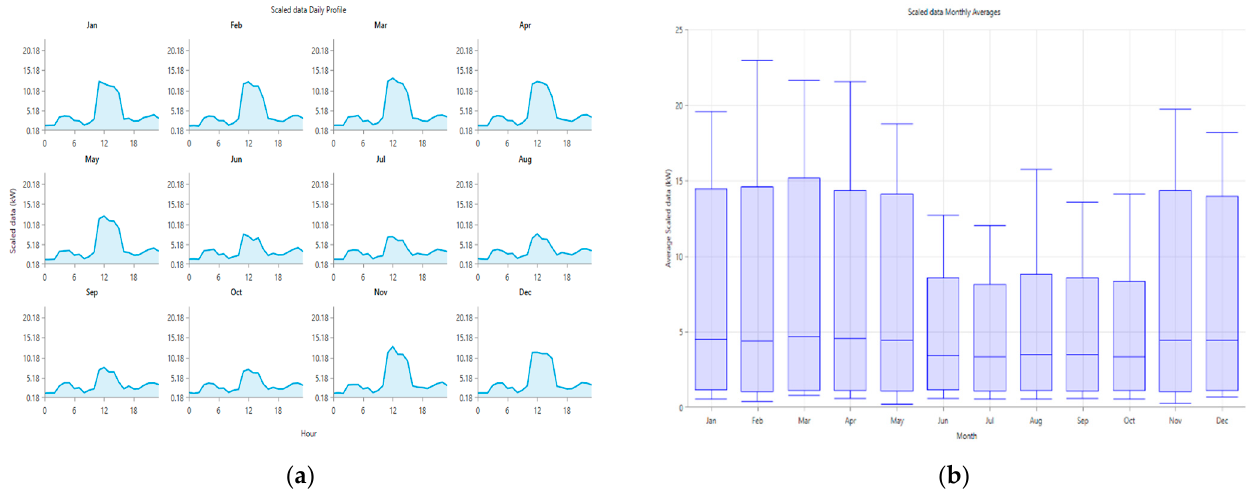
Figure 5. Scaled load profile for each month: ( a ) daily load profile, ( b ) monthly average.